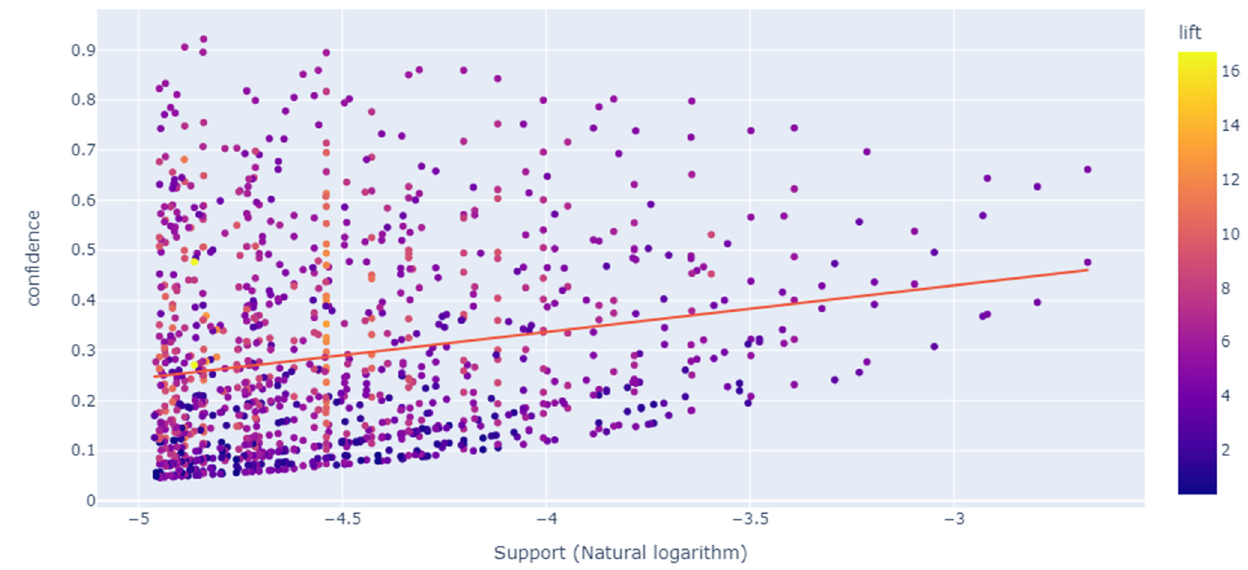
Figure 11. Generated association rules metrics correlation with a logarithmic support value on the x -axis. x